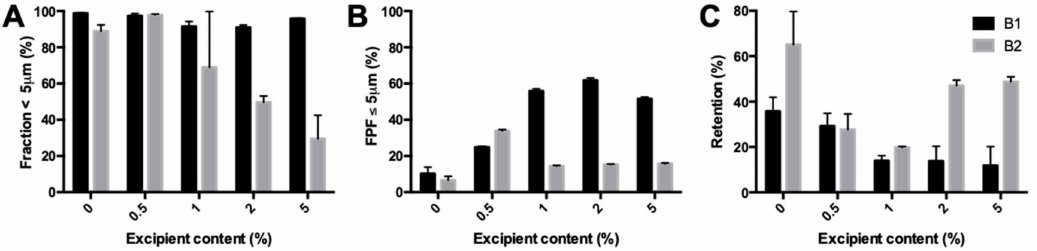
Figure 6. Primary particle size distribution and dispersion data of milled isoniazid with di ff erent amounts of l -leucine. ( A ) shows the fraction < 5 µ m found with the RODOS. ( B ) shows the FPF found in the dispersion measurement with a dose of 25 mg and a pressure of 4 KPa. ( C ) is the retention found during